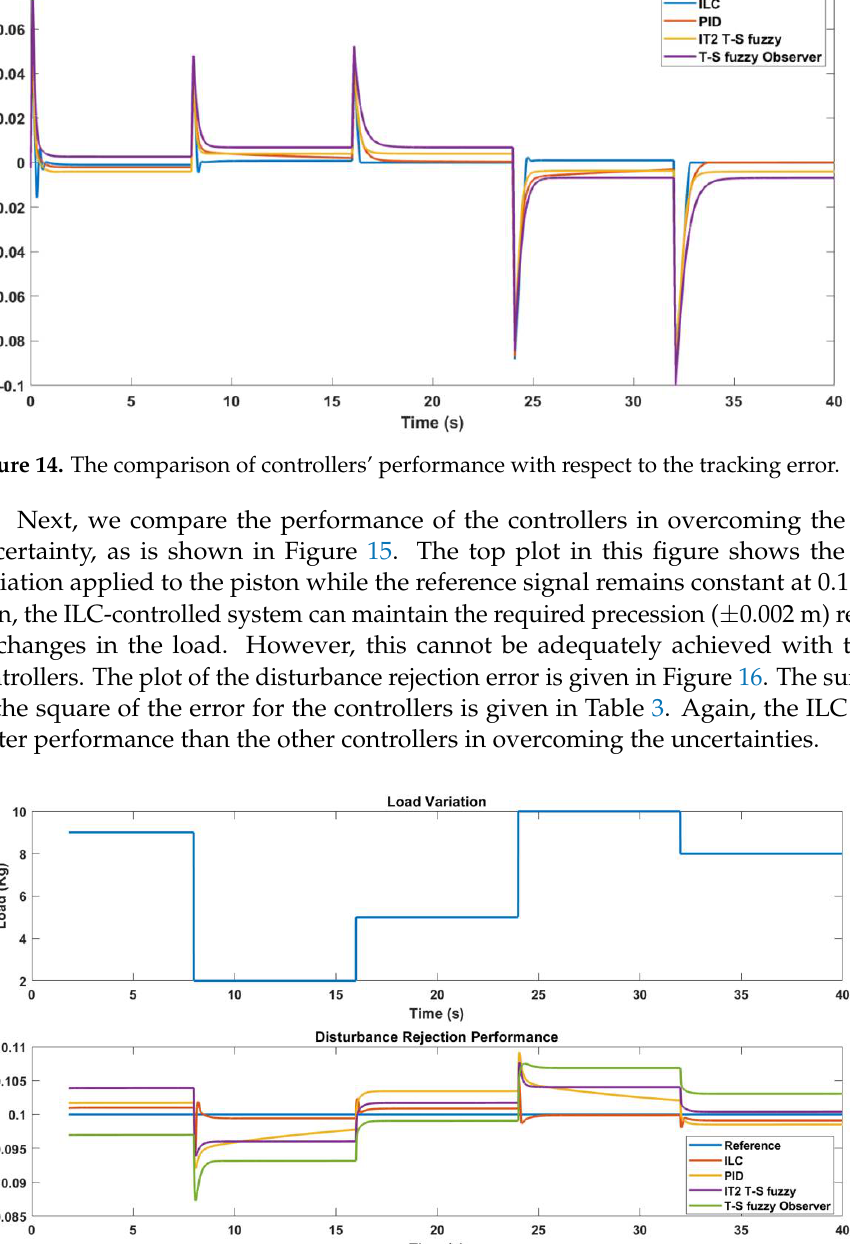
Figure 15. The comparison between the controllers’ performance in the disturbance rejection.